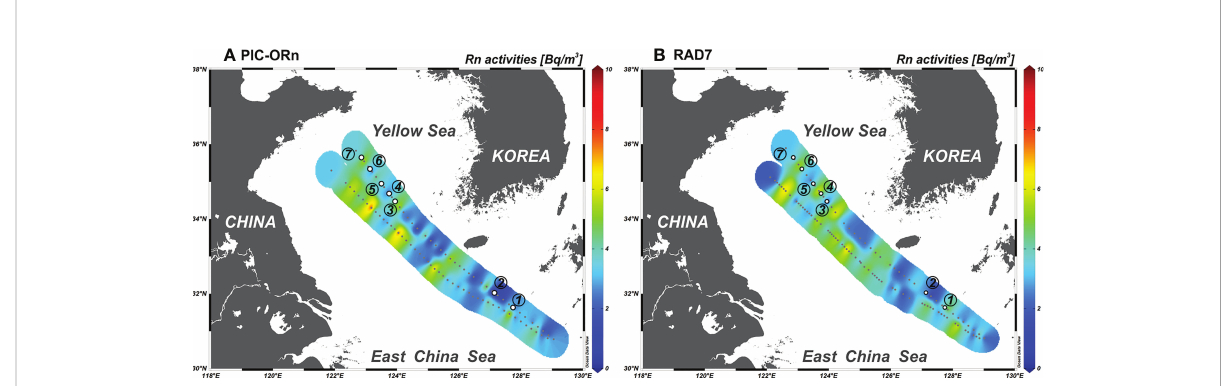
FIGURE 6 Distributions of dissolved radon activities measured by the PIC-ORn (A) and RAD7 (B) in surface waters of the northwest Paci fi c Ocean in June 2021, respectively. The circled numbers 1-7 represent discrete grab samples collected and measured via Lucas cell counting to compare with the automated